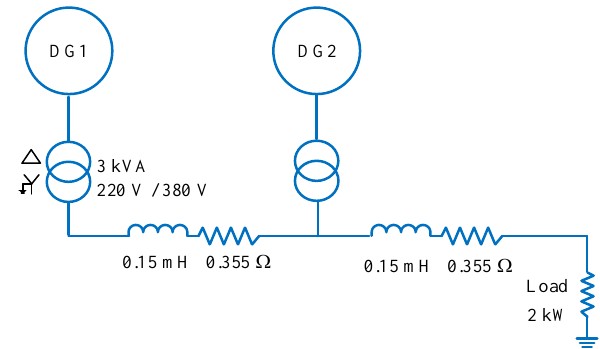
Figure 11. Tested microgrid (MG) system with two parallel inverters.